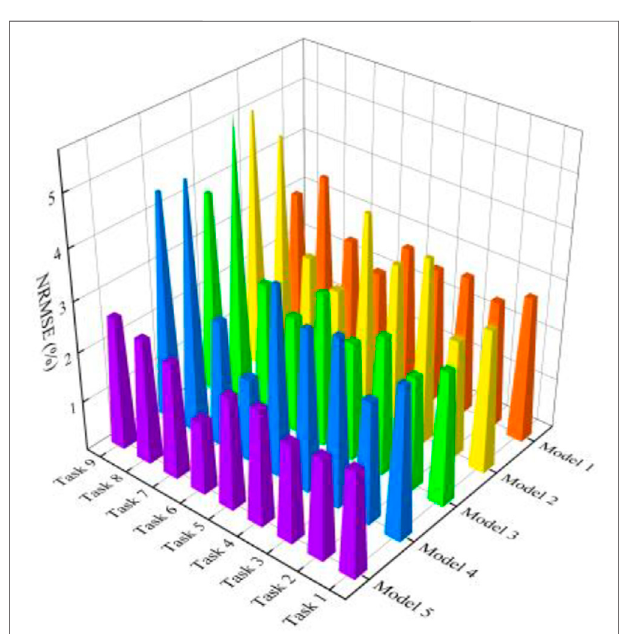
FIGURE 8 | NRMSE of models in different prediction tasks.